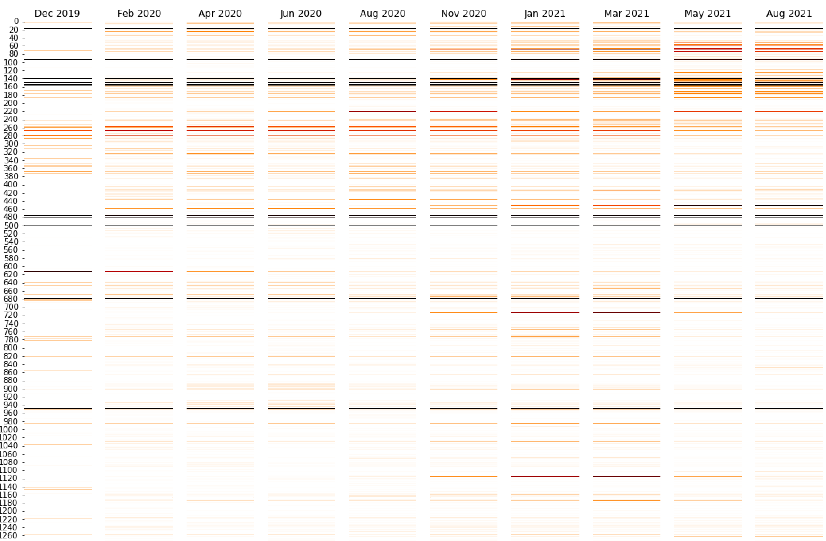
Figure 3. Mean attention at each amino acid position for sequences in the validation data set (aligned sequences occurring 2 or 3 times in the 1 October 2021 global data set) categorized into bins based on the date of first emergence. The intensity of the color is proportional to the attention log-normalized by the maximum attention for all sequence positions, such tat the peak values are black and intermediate attention levels are various shades of red. The mean attention values vary over time as waves of new virus genome variants emerge. For example, spike protein amino acid sites between 600 and 1200 become important as Alpha emerges in the winter of 2020-21. Some specific positions, e.g., 478 and 681, have high attention throughout time because of their changes from earlier in the development of the pandemic, Alpha, to the later Delta variant. More attention is paid to other sites, such as 452, which is characteristic in Delta, as the become a more significant indicator of the difference in a novel variant as it